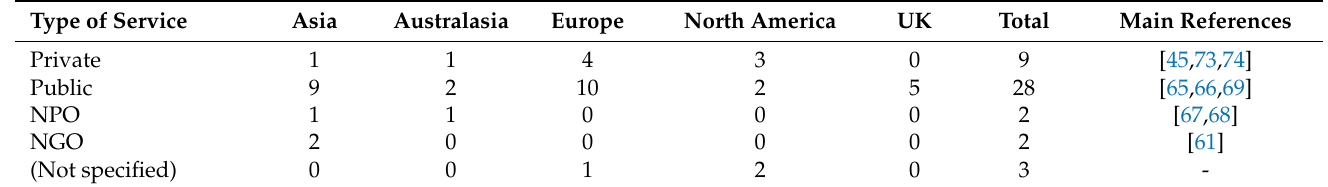
Table 5. Typologies of service of the selected studies classified by country